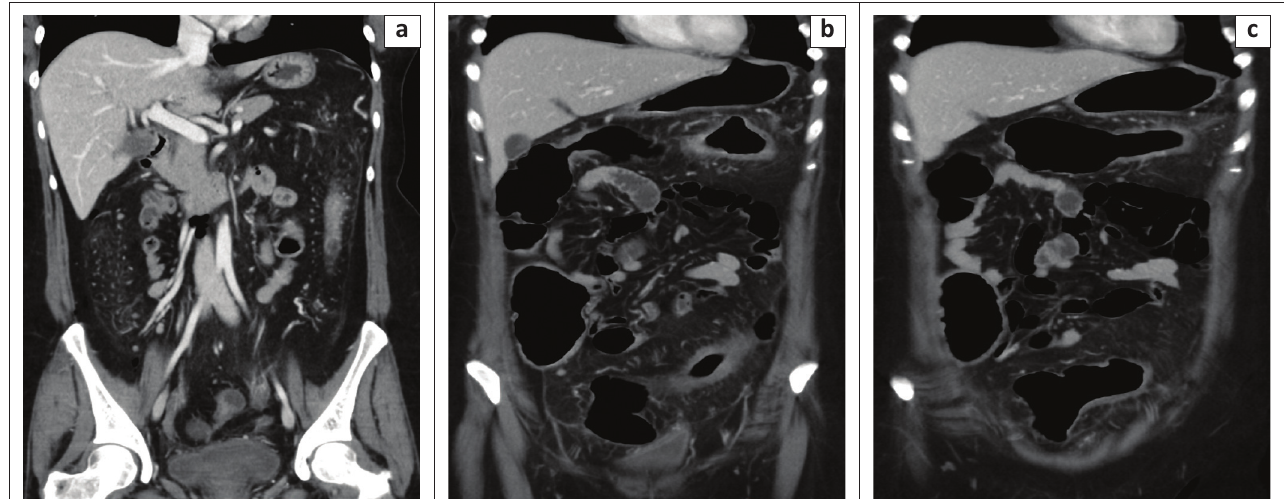
FIGURE 1: Coronal reformat images (a, b and c) of the abdomen in venous phase after intravenous (IV) contrast administration.